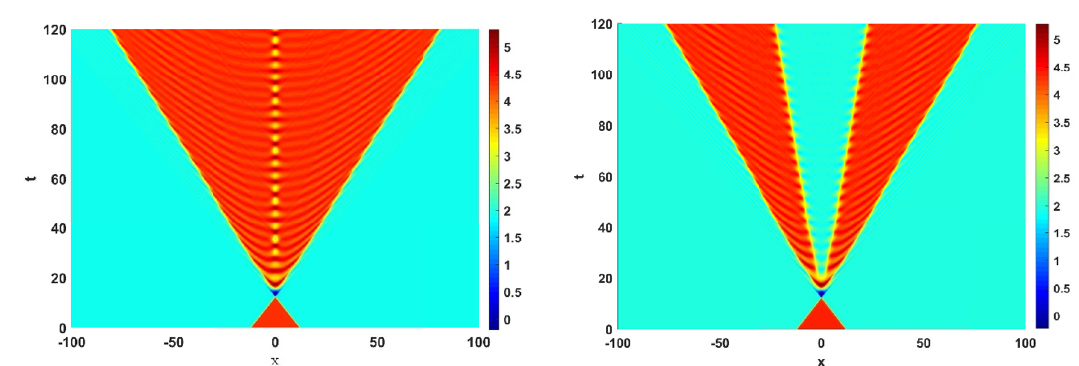
Figure 23 . Small kink-antikink collision, showing a) the production of oscillation wave at x = 0 for v = 0 . 97. b) the production of two small kink-antikink pair in the same topological sector for v = 0 . 975. For both figures we fixed r = 0 .